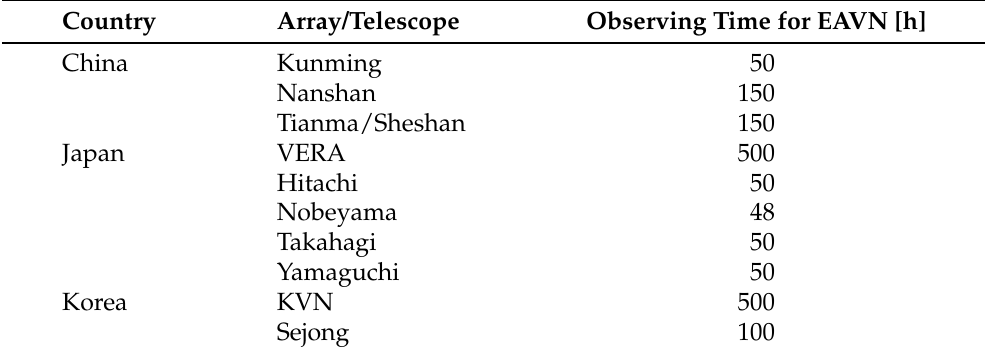
Table 5. Total observation time of EAVN provided by each telescope for the open-use program in the 2022B semester.